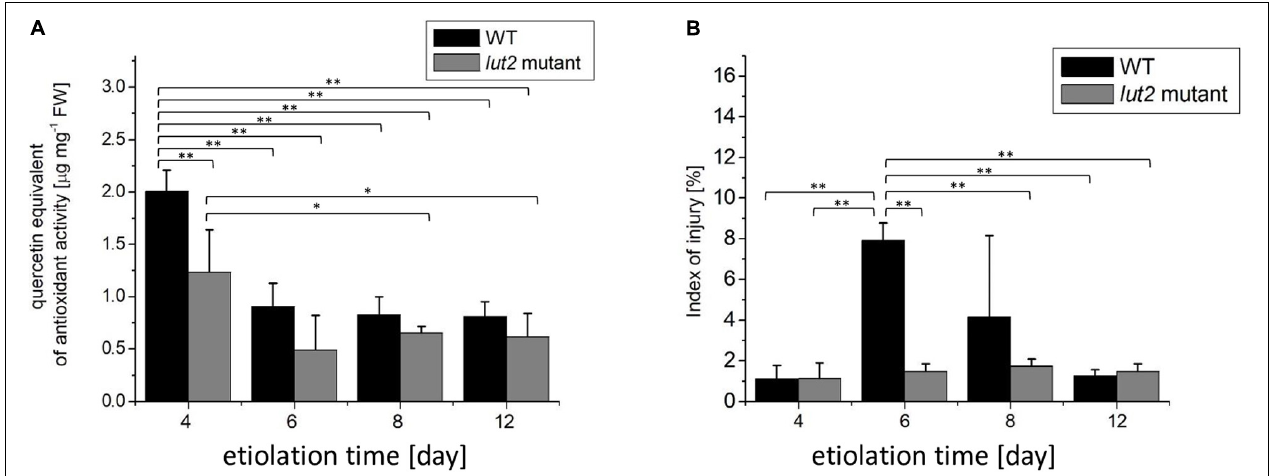
FIGURE 2 | Total antioxidant activity and ion leakage in etiolated WT and lut2 mutant. (A) Total antioxidant activity of seedling extracts based on the EPR signal of DPPH expressed as quercetin equivalent. (B) The index of injury expressed as percentage of ion leakage at certain condition to maximum ion leakage. Bar heights represent arithmetic mean, while error bars represent SD, n = 4. Statistically significant differences from two-way ANOVA and post hoc Tukey test were indicated using ∗∗ p < 0.01; ∗ p < 0.05.